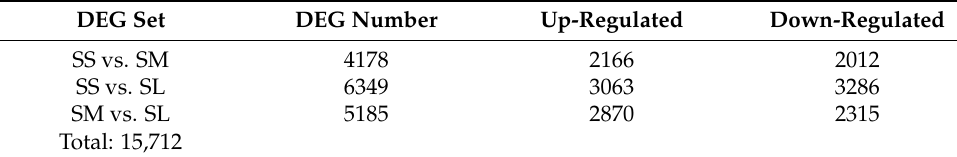
Table 1. Statistics of